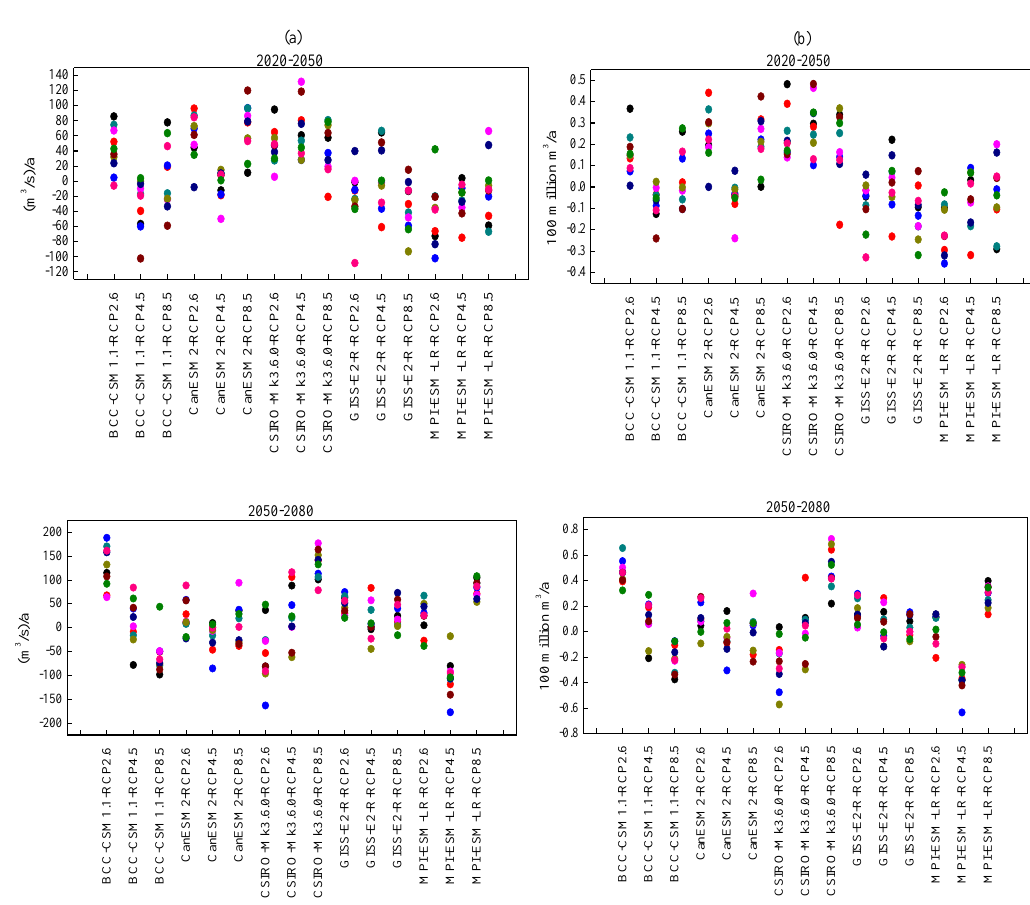
Figure 4. Trends per annum for ten simulated samples of (a) AMX1d and (b) AMX7fv under different emission scenarios.